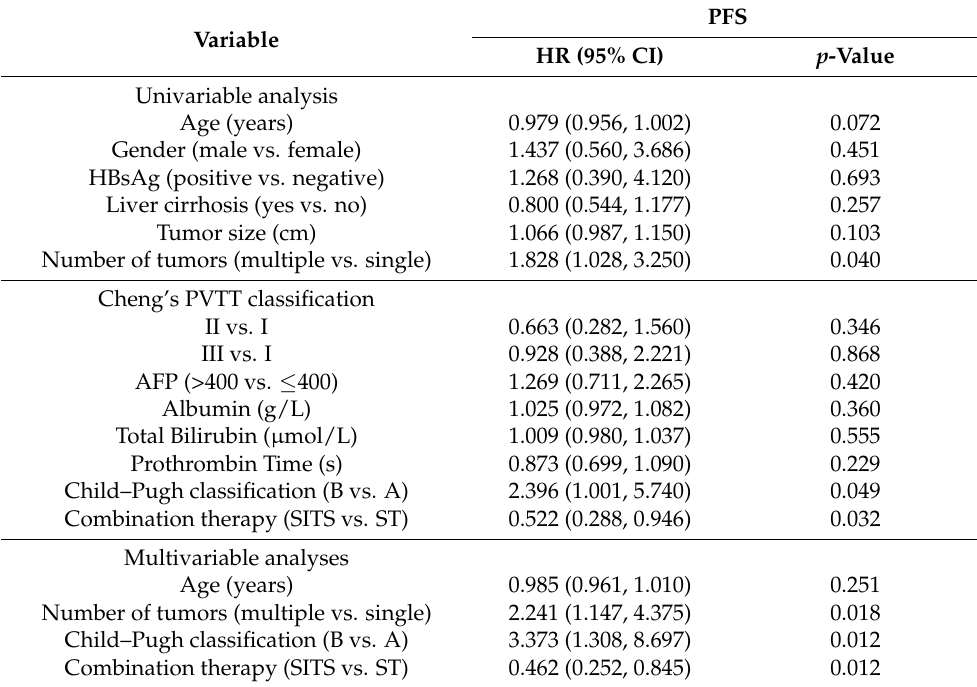
Table 3. Univariable and multivariable analyses of risk factors for PFS in advanced HCC cases accompanied by PVTT.